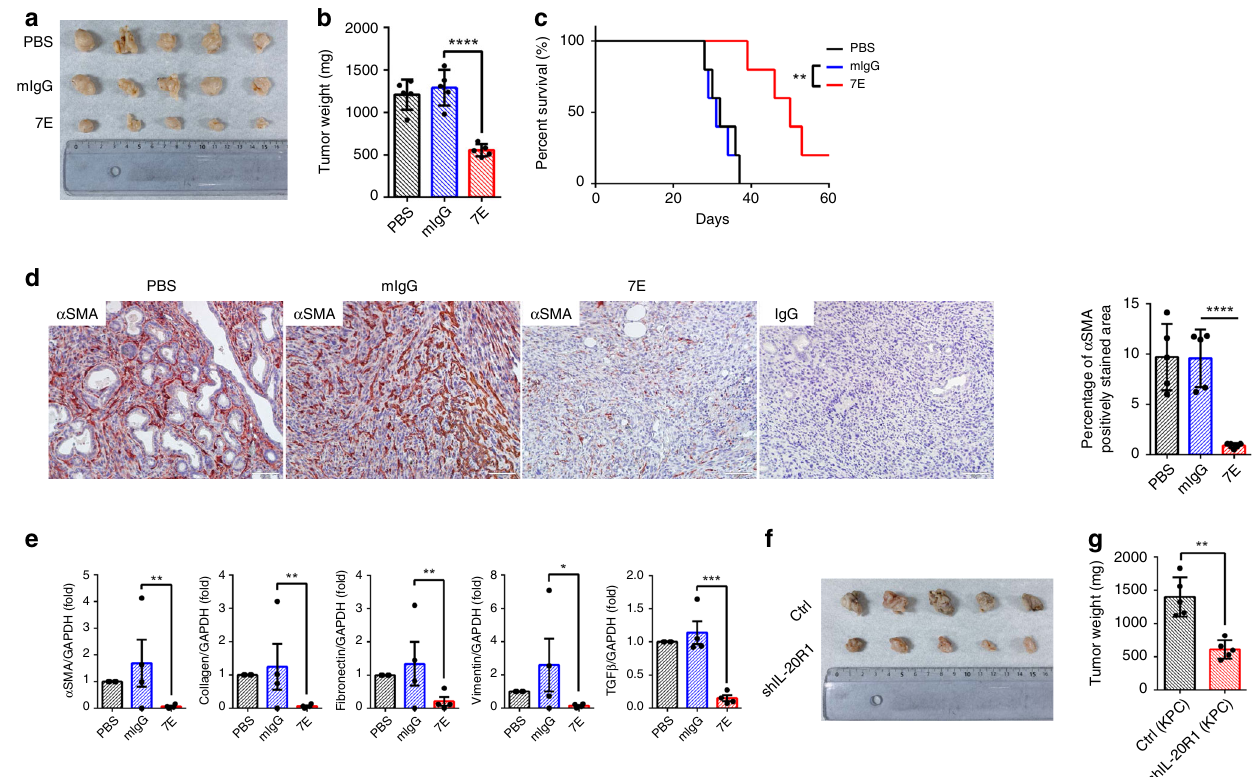
Fig. 2 Tumor growth was inhibited in 7E-treated and IL-20R1-knockdown KPC cell-injected orthotopic models of PDAC. KPC cells were injected into the pancreas of WT mice, which were then treated (i.p.) with PBS, mIgG, or 7E ( n = 5) twice per week for 28 days. Mice that were not injected with cancer cells served as healthy controls ( n = 3). a , b The tumors were collected on day 28, measured, and weighed. One-way ANOVA, p < 0.0001. **** p < 0.0001 compared with mIgG-treated controls. c Mice were randomly divided into three groups ( n = 5) and treated with PBS, mIgG, or 7E twice per week until the end of the study. Kaplan – Meier survival analysis showed prolonged survival for the 7E-treated orthotopic model mice. Log-rank p value = 0.0028; ** p < 0.01 compared with mIgG-treated controls. d Representative IHC and quanti fi cation were performed for α SMA in PDAC tumors from KPC mice (each group, n = 5). Original magni fi cation: ×200; scale bar, 50 μ m. The rightmost panel shows the IgG-stained negative control. One-way ANOVA, p < 0.0001. e Transcript levels of α SMA (one-way ANOVA, p = 0.0099), Collagen (one-way ANOVA, p = 0.011), Fibronectin (one-way ANOVA, p = 0.0144), Vimentin (one-way ANOVA, p = 0.0282), and TGF- β (one-way ANOVA, p < 0.0001) were determined by RT-qPCR analysis of pancreatic tumors (each group, n = 4). * p < 0.05, ** p < 0.01, and *** p < 0.001 compared with mIgG-treated controls. f , g KPC or IL-20R1-knockdown KPC cells were injected into the pancreas of WT mice ( n = 5). Tumor images are shown ( f ), and tumors weights ( g ) were measured. ** p = 0.0079 compared with the control group. Data are shown as the mean ± SD in b – d , g . Data are shown as the mean ± SEM in e . Statistical signi fi cance was determined by one-way ANOVA Sidak ’